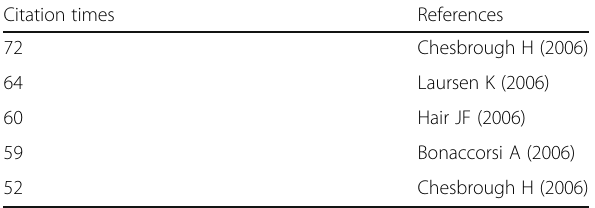
Table 4 The five most cited papers in the “ open source ” cluster Citation